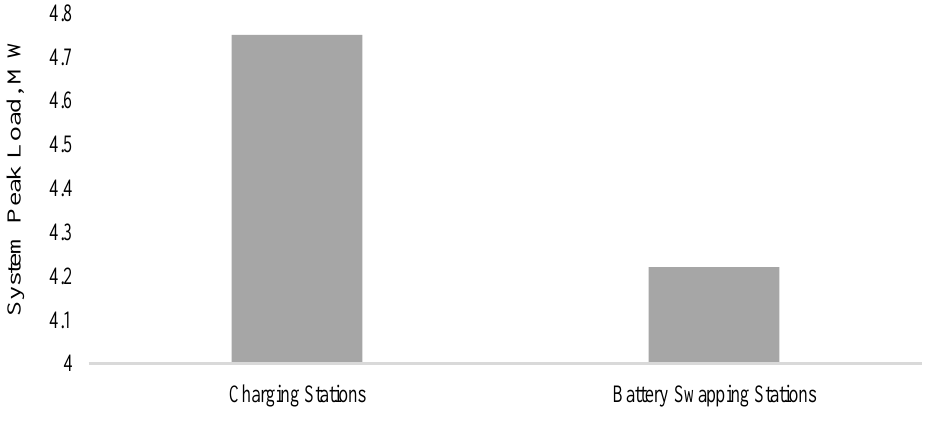
Figure 9. The distribution system’s peak load considering charging and battery-swapping